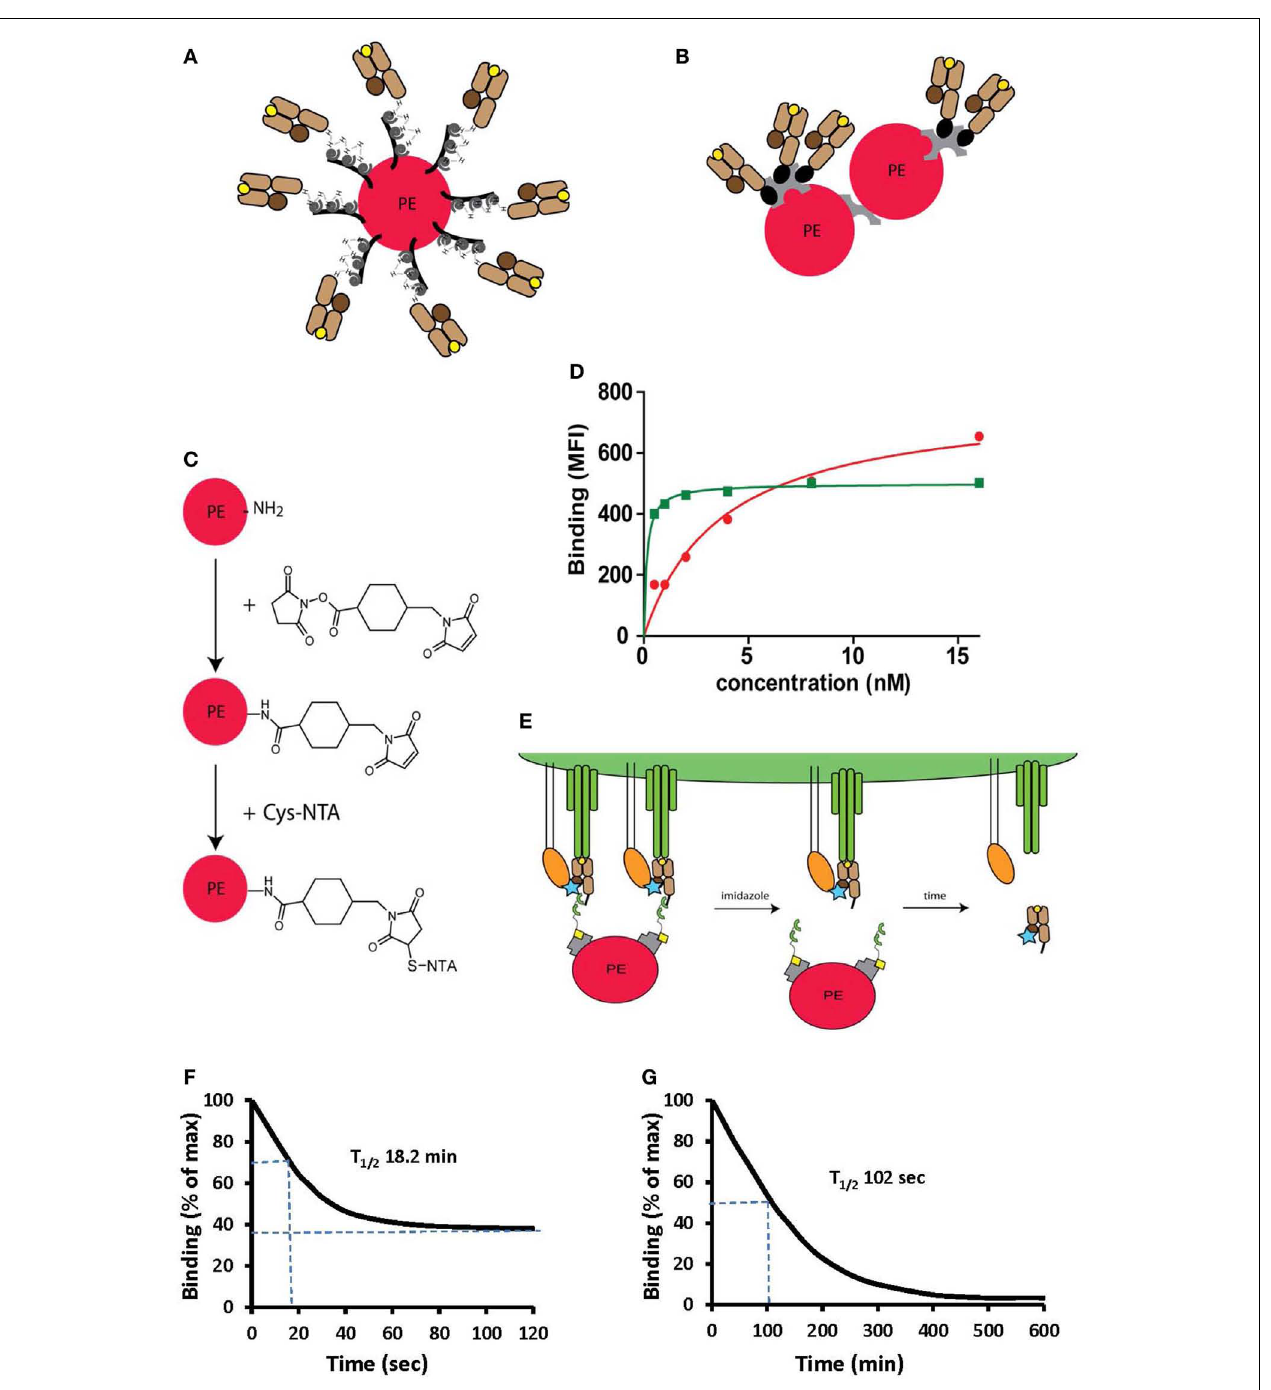
fromT cells. Imidazole induced rapid decay of cell-associated NTAmers and disappearance of PE fluorescence, followed by slower dissociation of Cy5 labeled blue monomers from the cells. (F) Cloned Flu matrix-specific CD8 + T cells were stained in the cold with conventional A2/Flu 58–66 PE multimers, washed and cell-associated PE fluorescence measured by flow cytometry after the indicated periods of time. (G) Alternatively the cells were labeled with PE-NTAmers containing Cy5 conjugated A2/Flu 58–66 monomers and the monomer dissociation from the cells was assessed by flow cytometry as illustrated in (E) .The inserted numbers indicate the dissociation half-lives T 1/2 . Presented data were derived from (33) and